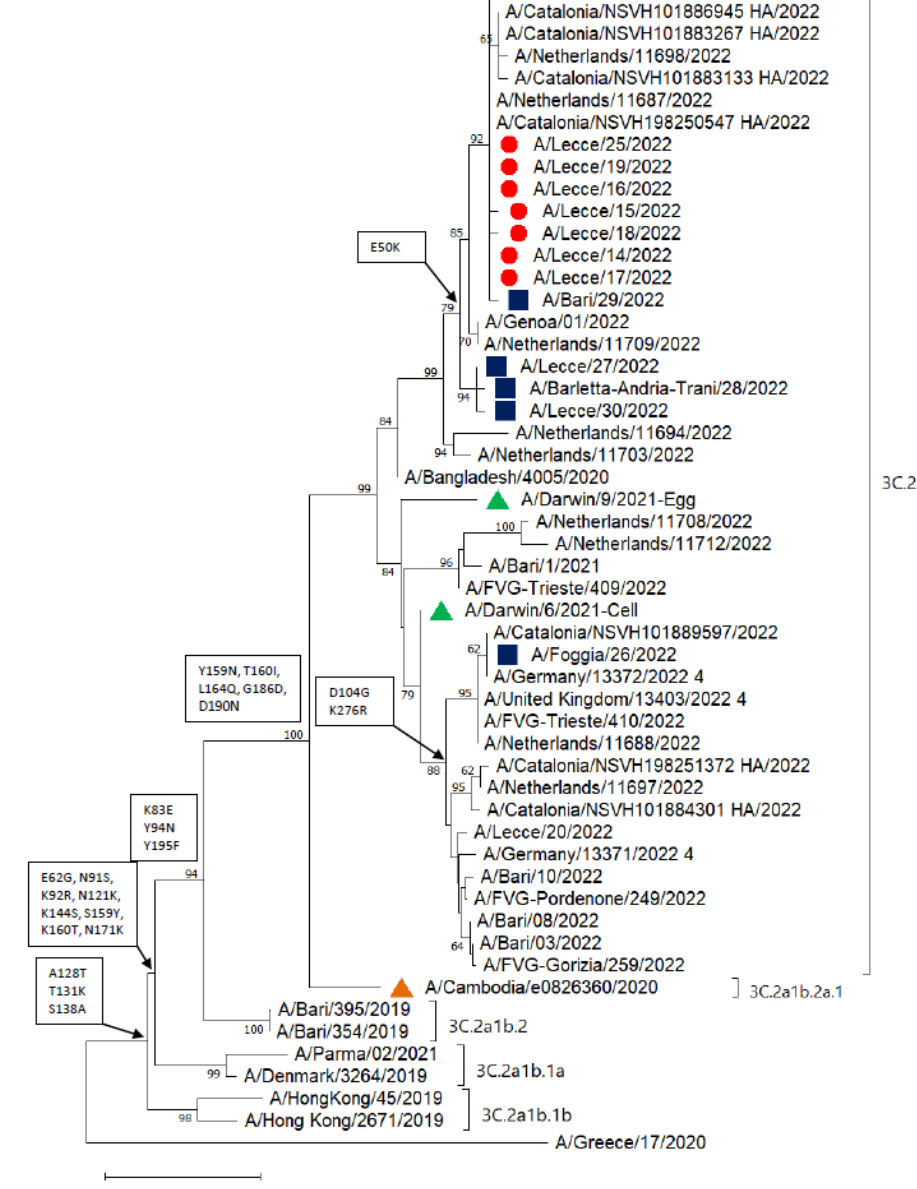
Figure 2. Phylogenetic analysis of the hemagglutinin (HA) gene of 12 A/H3N2 influenza viruses characterized in the Apulia region of Italy in August 2022. Red dots represent strains identified from the outbreak and blue squares represent sporadic strains; green triangles represent the vaccine strains for the 2022 – 2023 season, and the orange triangle represents the vaccine strain for the 2021 – 2022 season. The phylogenetic tree was constructed using Mega 11 software, applying the neighbor- joining algorithm. The evolutionary distances were calculated using the Kimura 2-parameter method. Amino acid substitutions defining specific genetic clusters are shown at the nodes. Genetic clades are shown to the right of the tree, and the scale bar represents the nucleotide substitutions